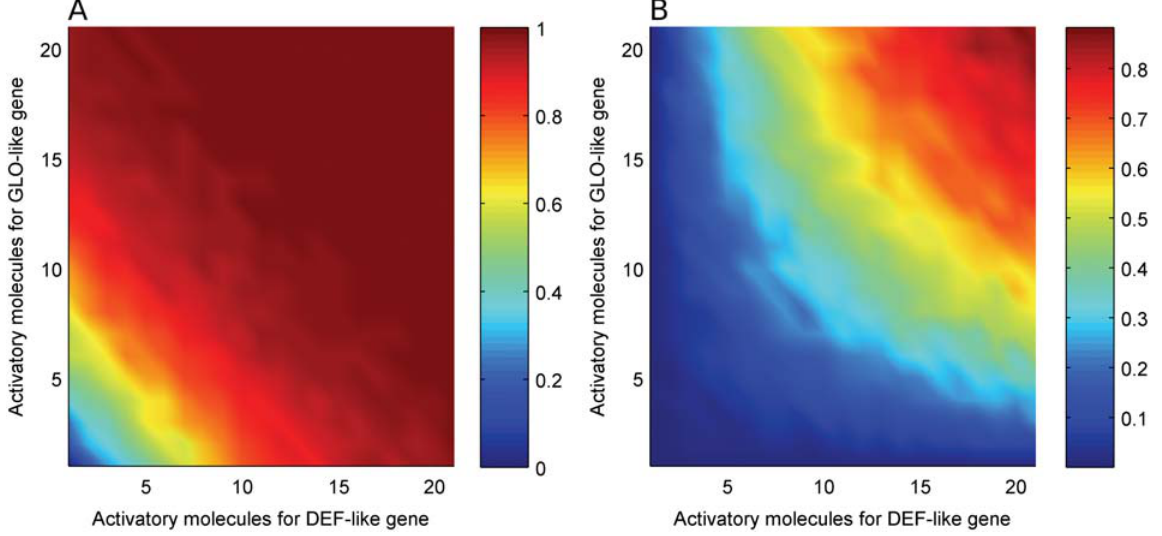
Figure 3. Switching behavior of the two-gene circuits simulating two independent inputs, under (A) facultative heterodimerization, and (B) obligate heterodimerization. X- and Y-axes denote the number of available input molecules for DEF and GLO, respectively. The probability of ending in the ON state is indicated by color: blue is low, red is high. Parameters are as in Table S2.